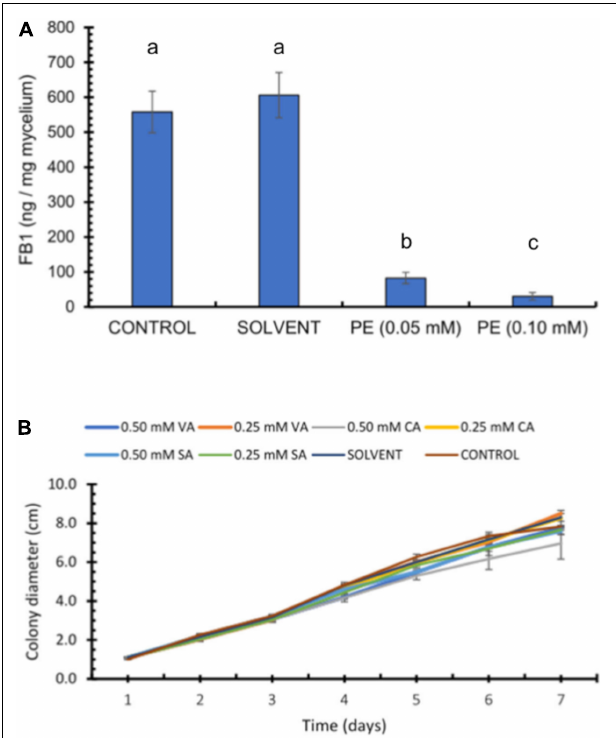
FIGURE 5 | Effect of pericarp extracts (PE) on fumonisin production. (A) 1.25 × 10 5 F. verticillioides conidia were inoculated in GYAM medium containing pericarp extracts adjusted to contain 0.05 or 0.1 mM FA. FB1 levels were analyzed by HPLC of the OPA fluorescent derivatives; values are means ± SD, and different lowercase letters indicate significant differences, as analyzed by one-way ANOVA followed by Tukey’s comparison test ( n = 4; p < 0.05). (B) Effects of phenolic acids on F. verticillioides radial growth. Colony diameter of F. verticillioides (5 × 10 3 conidia inoculum) growing on PDA plates containing vanillic acid (VA), coumaric acid (CA), or syringic acid (SA) (0.25 and 0.50 mM).